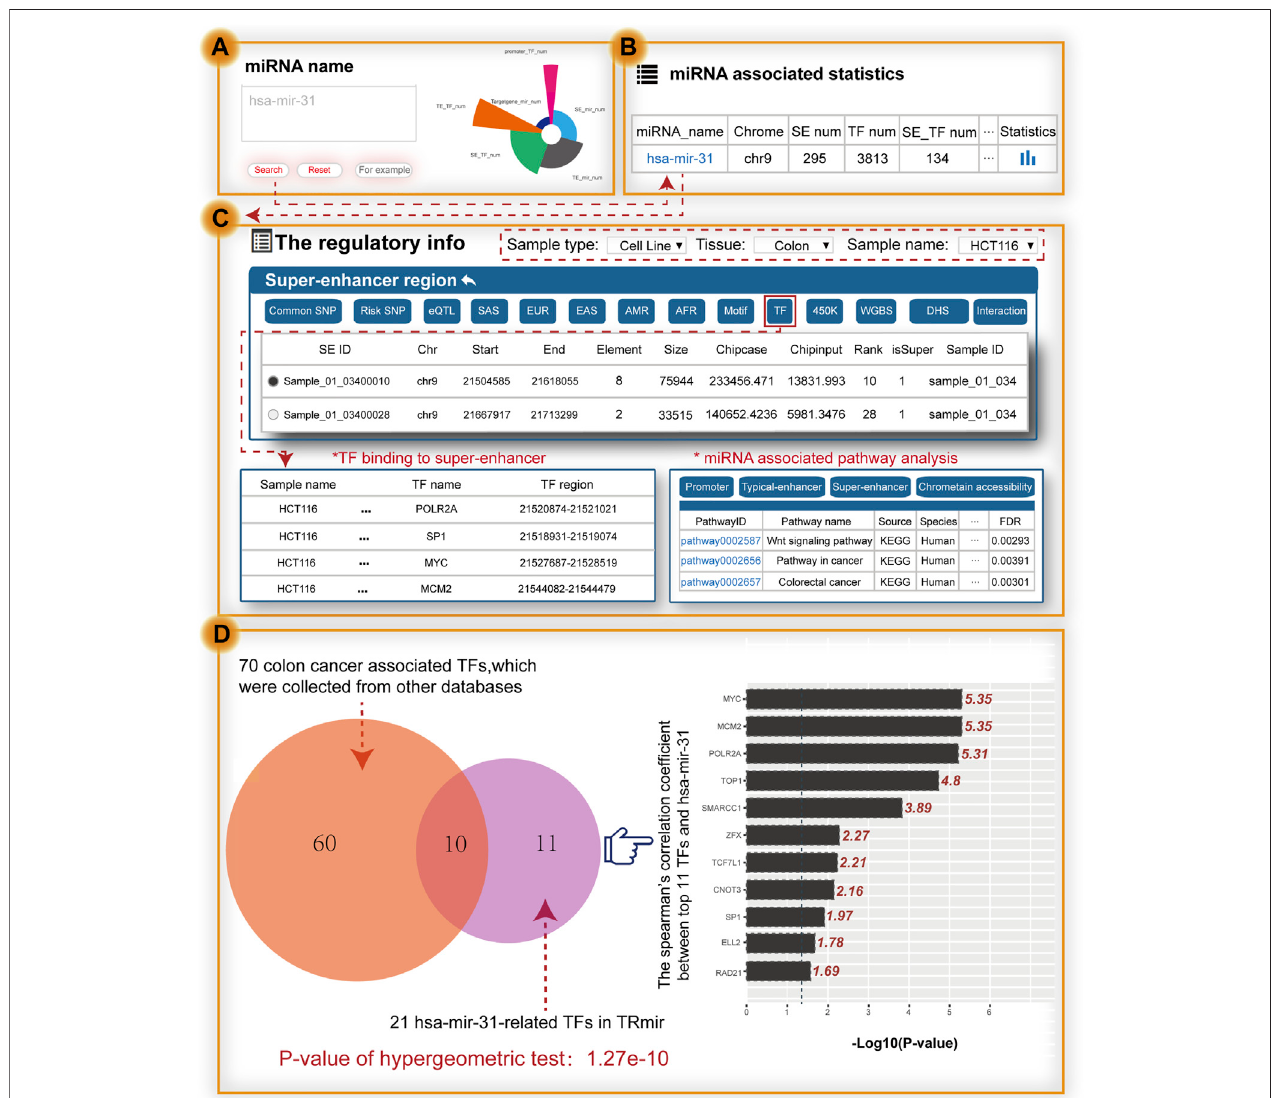
FIGURE 3 | Main functions and usage of TRmir. Relevant validation results were obtained by inputting hsa-mir-31. (A) Search by miRNA. (B) Brief statistics on geneticannotationofhsa-mir-31. (C) FromtheperspectiveoftheSEregionshownonthedetailspageforhsa-mir-31,wecanobtaindetailedinformationaboutpathway analysis, and TFs enriched in the regulatory regions. (D) Analysis of hsa-mir-31 – related TFs. These related TFs are enriched in the related regulatory regions. The right panel shows the calculation results for Spearman ’ s coef fi cient ( p -value = 0.05, the − logP-value cutoff value is 1.301).